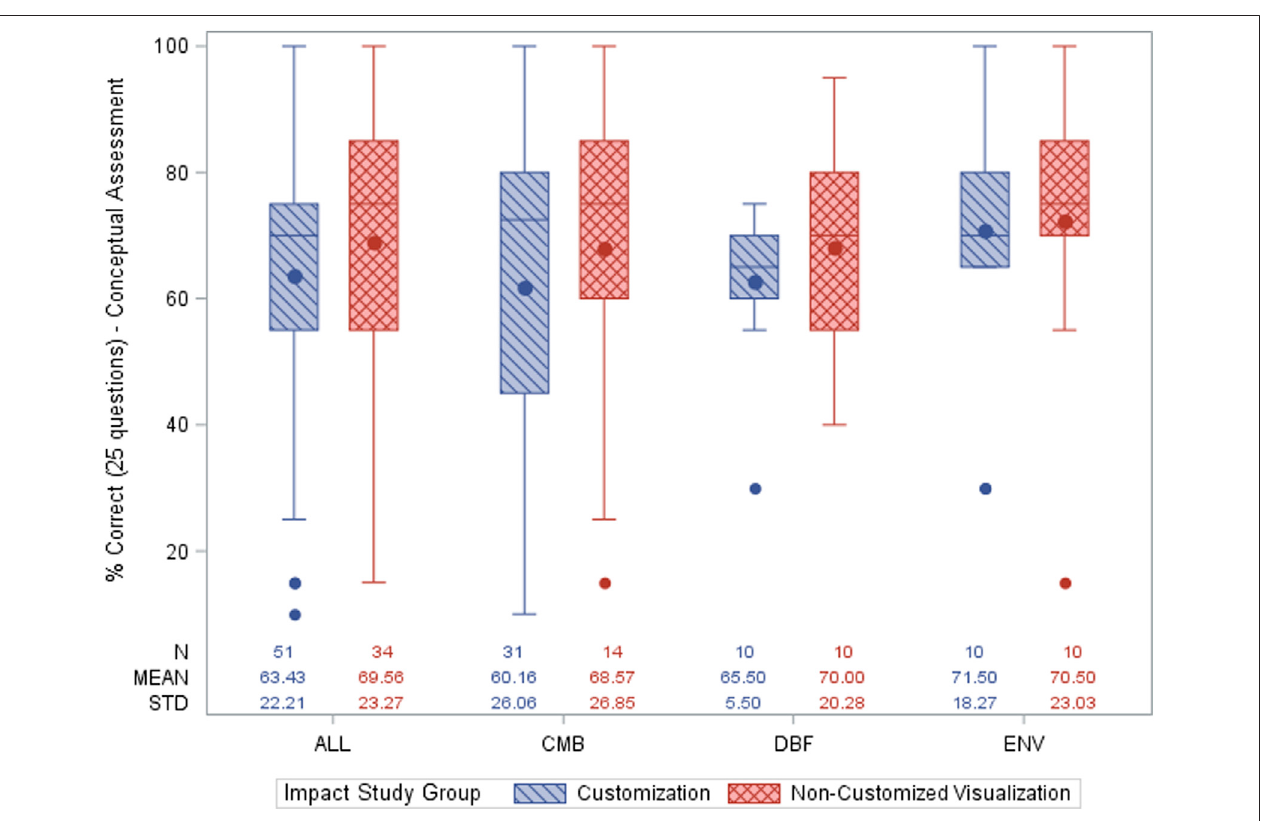
FIGURE 3 | Comparison of the database content score (%) for study groups: Overall (ALL) and across all three courses (CMB), (DBF), (ENV).